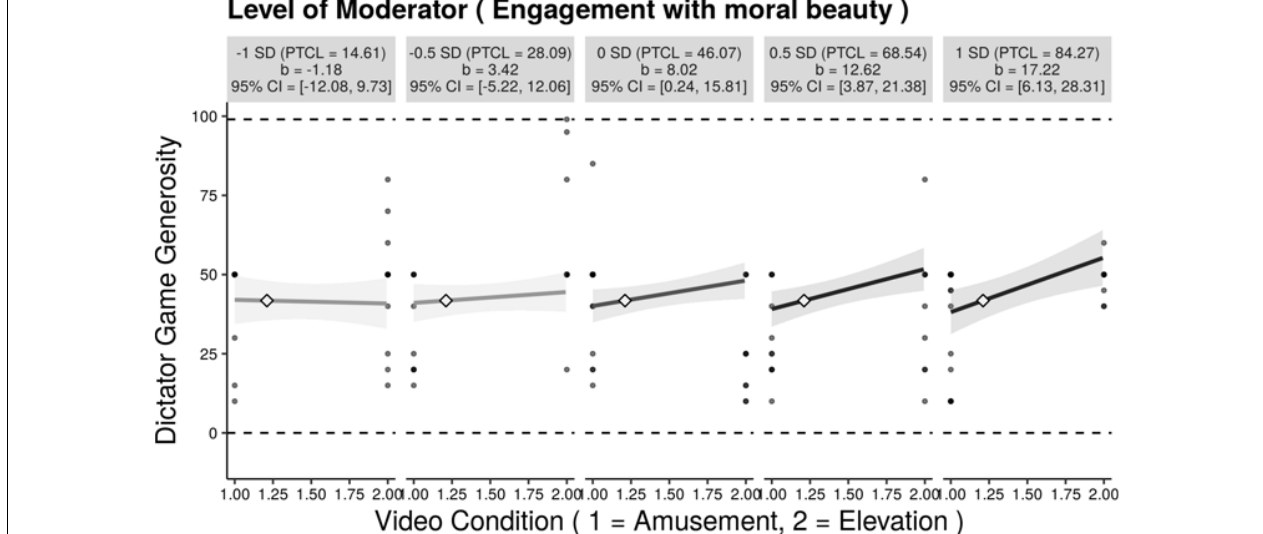
dependent prosocial variables, namely the one that was most closely related to altruism: dictator game generosity (Baumert et al.,